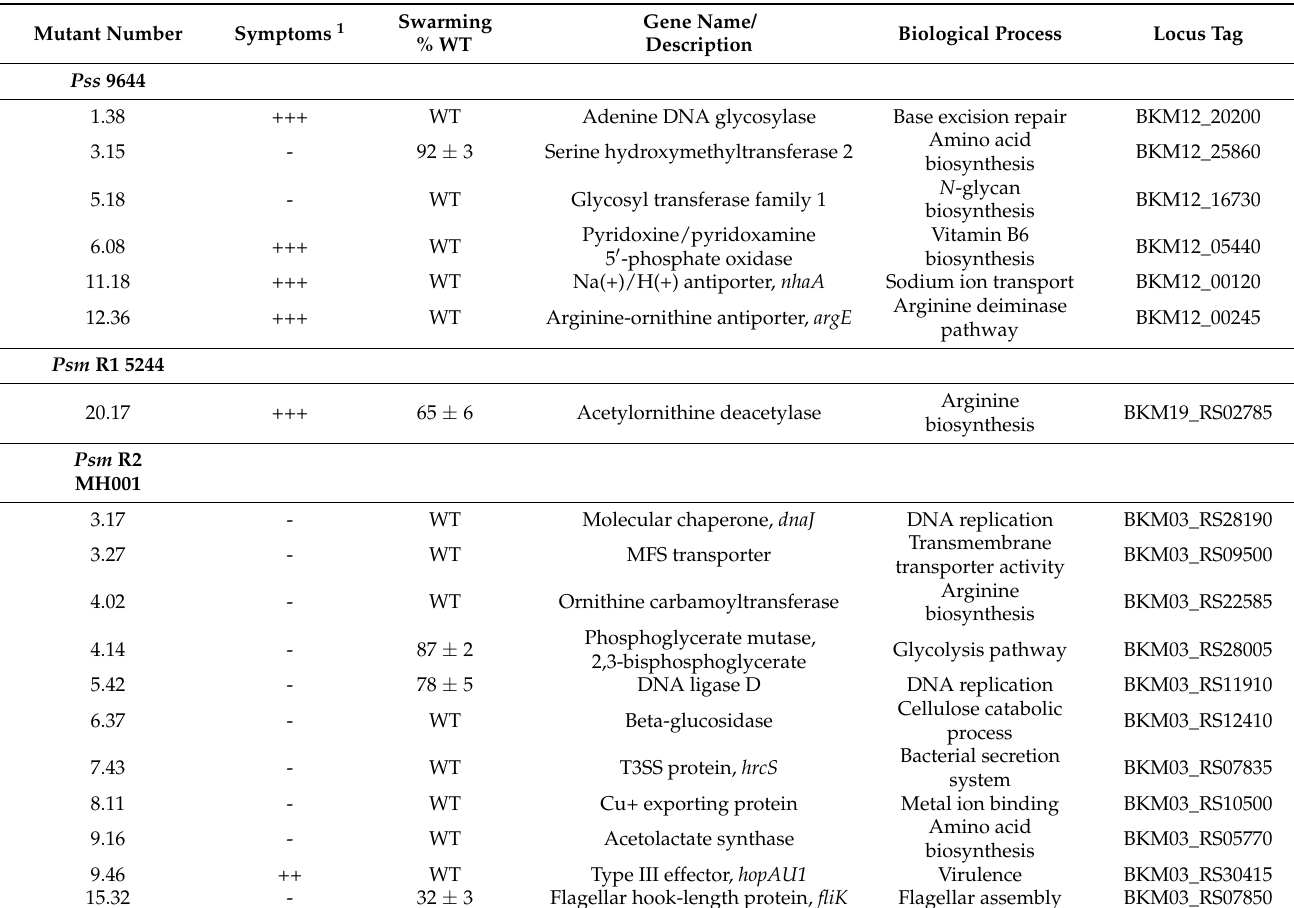
Table 3. Characteristics of selected Pseudomonas syringae transposon